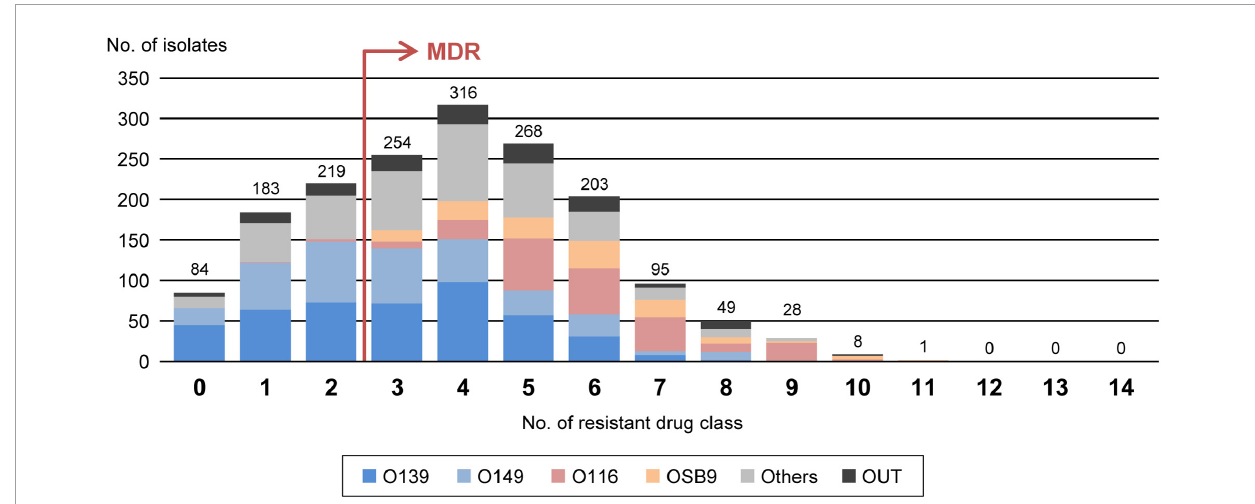
FIGURE3 Comparisons of multidrug resistance levels among each O serogroup. The x -axis shows the number of drug classes to which the isolates in the serogroups are resistant. MDR isolates are defined as isolates that are resistant to three or more drug classes, as indicated by the red arrow. The numbers of isolates presenting resistance to each drug class are indicated above the bars. O serogroups are indicated with the same colors as those in Figure 1 .